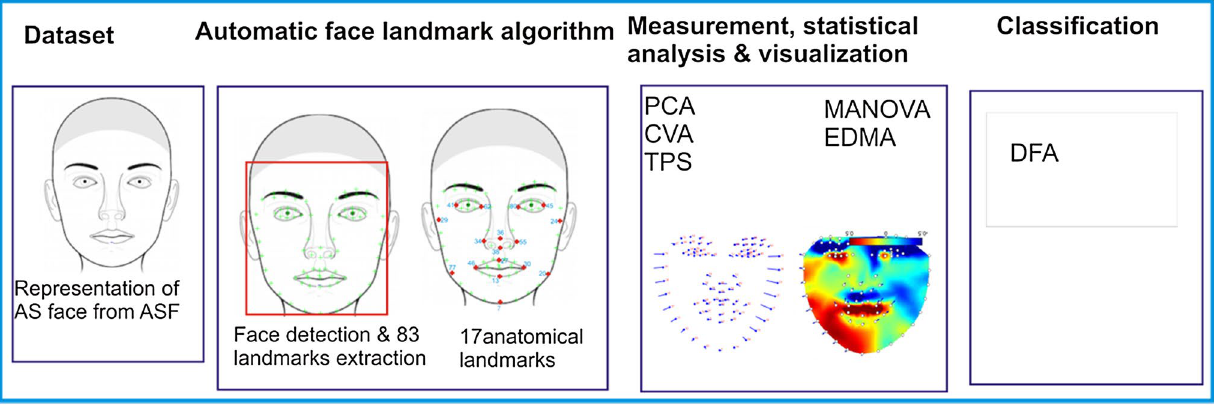
Figure 1. Architectural diagram for the proposed